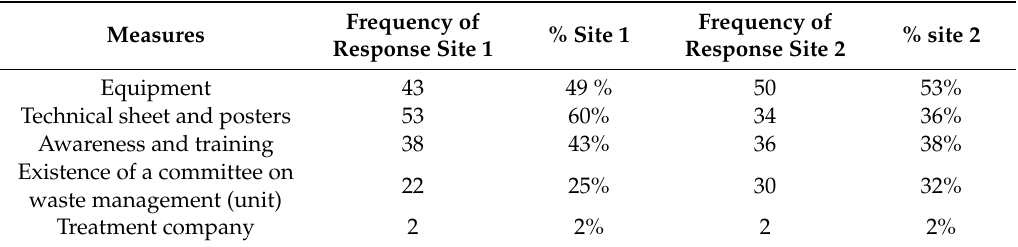
Table 3. Comparison of measures reported by sta ff regarding infectious waste